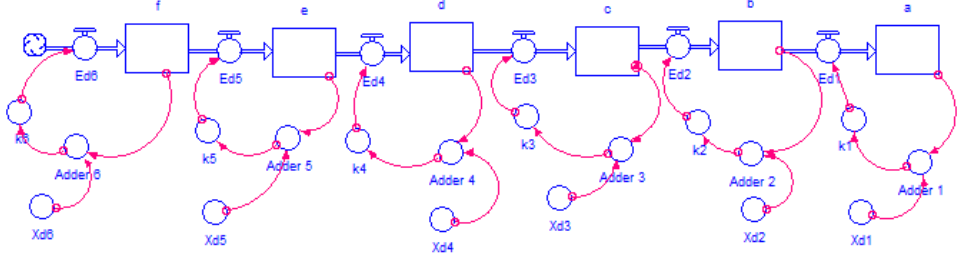
Figure 29. Forrester diagram of the finishing process with six state variables.